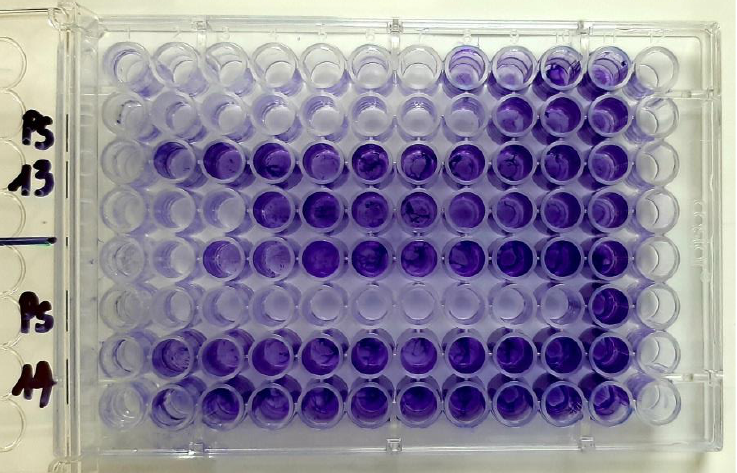
Figure 12. The chart of MBEC values of essential oils from different sources: (a) comparison of MBEC values of tea tree from different sources, (b) comparison of MBEC values of thyme from different sources.